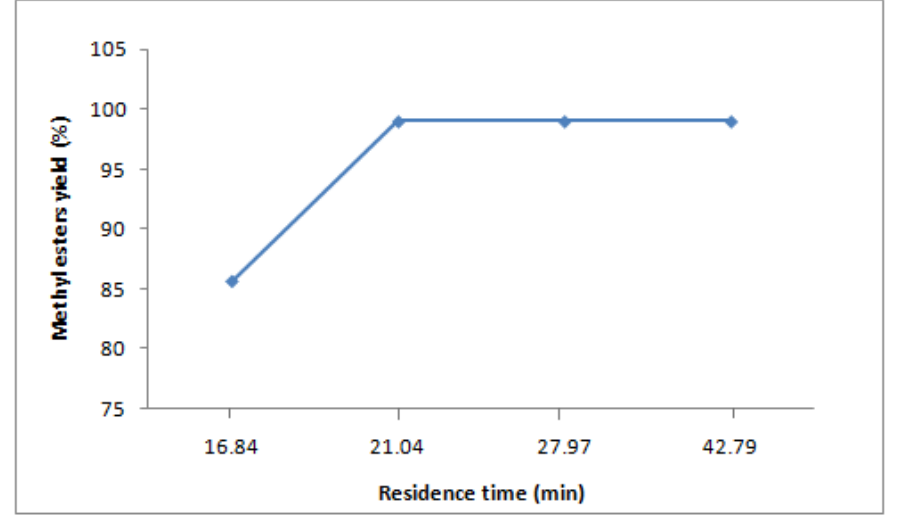
Figure 5. Effect of residence time on yield of methyl esters to coconut oil. (catalyst concentration 1 wt% of oil, molar ratio methanol:oil 7:1, temperature 65 °C, flow rate 142 mL/min, stirring speed 800